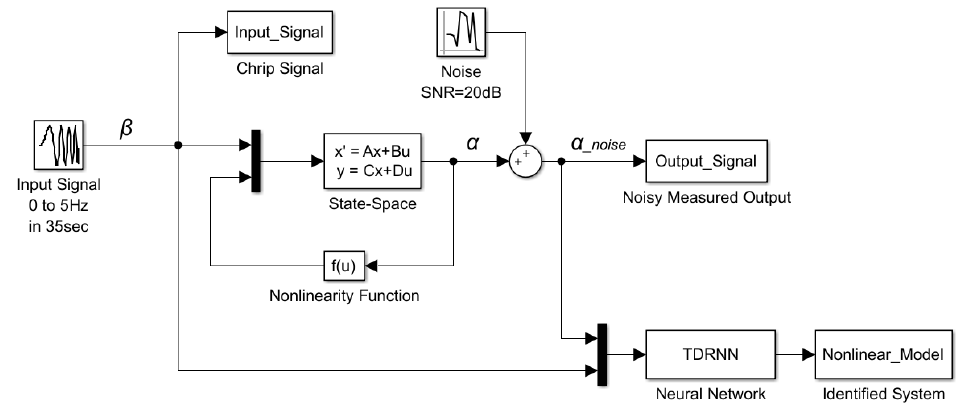
Figure 2. Flowchart for neural network identification. SNR: Signal-to-noise ratio.